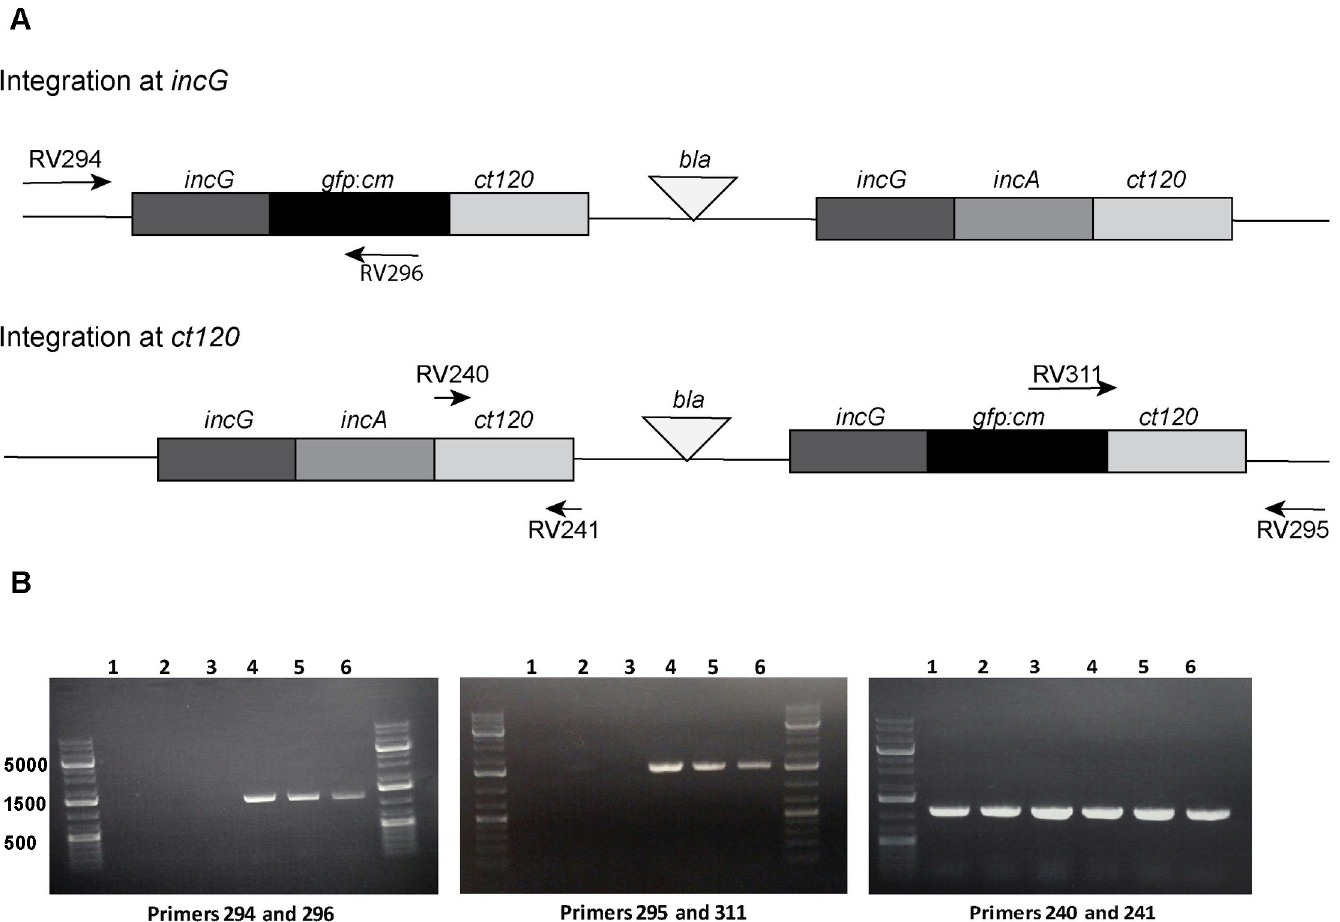
Fig 4. Plasmid pBVR2 integrates into the C . trachomatis chromosome at homologous regions. PCR amplification using DNA from the pBVR2 transformants was performed using primers specific for C . trachomatis chromosomal DNA: One outside of the cloned region (294 or 295), and one located within gfp : cat (296 or 311). Negative controls included non-transformed C . trachomatis L2 DNA (lane 1), C . trachomatis L2 transformed with plasmid pSW2 (lane 2), and plasmid pBVR2 DNA alone (lane 3). Primers 240 and 241, specific for ct_120 , were used as a positive PCR control. Lanes (4–5) contained chromosomal DNA from the C . trachomatis pBVR2 clones 5F and 6B. Lane (6) contained chromosomal DNA from the parent C . trachomatis pBVR2 transformant prior to cloning.